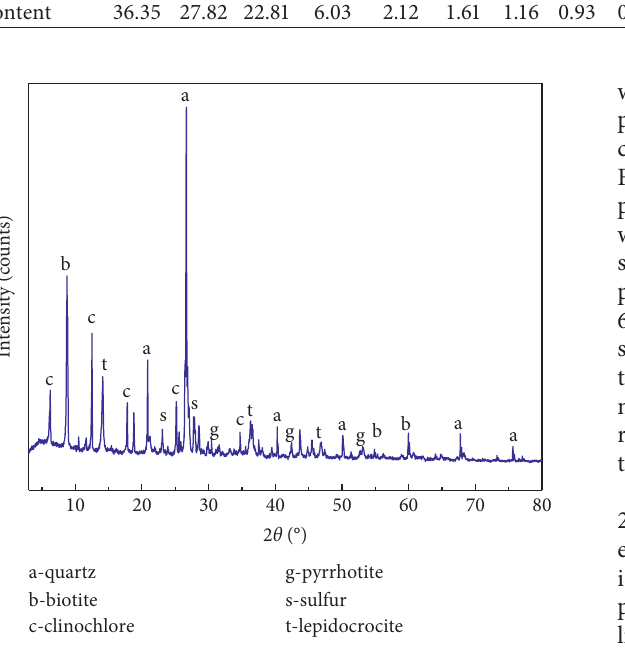
Figure 3: XRD spectra of the copper tailing sample